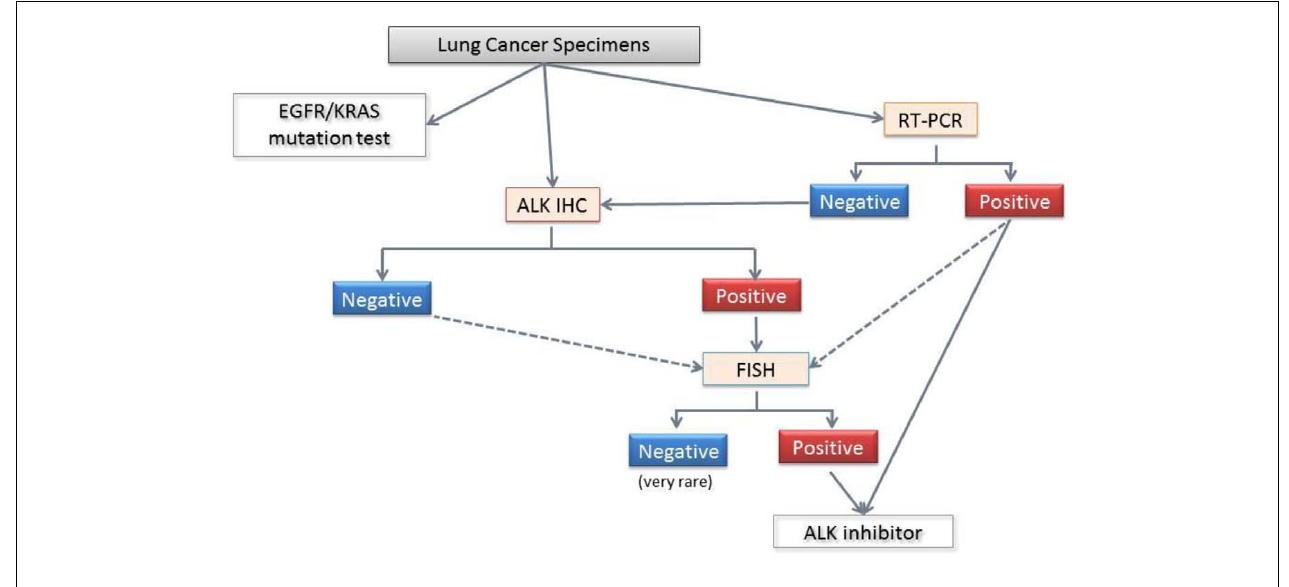
pattern, signet ring cells, andTTF-1 positivity in mucinous adenocarcinomas). For pleural effusions and/or cytology samples, a positive RT-PCR can confirm the ALK fusion and directly facilitate crizotinib treatment. However, a negative RT-PCR does not have any clinical significance, and further examinations are required. Because each method has advantages and disadvantages, the use of more than one method to detect ALK fusion is